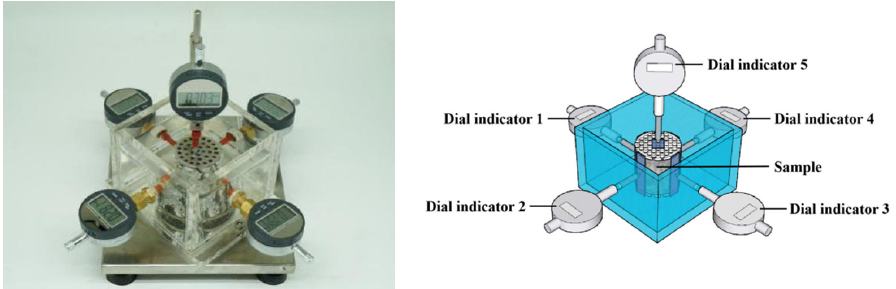
Figure 4. YS ‐ II rock ‐ swelling ratio